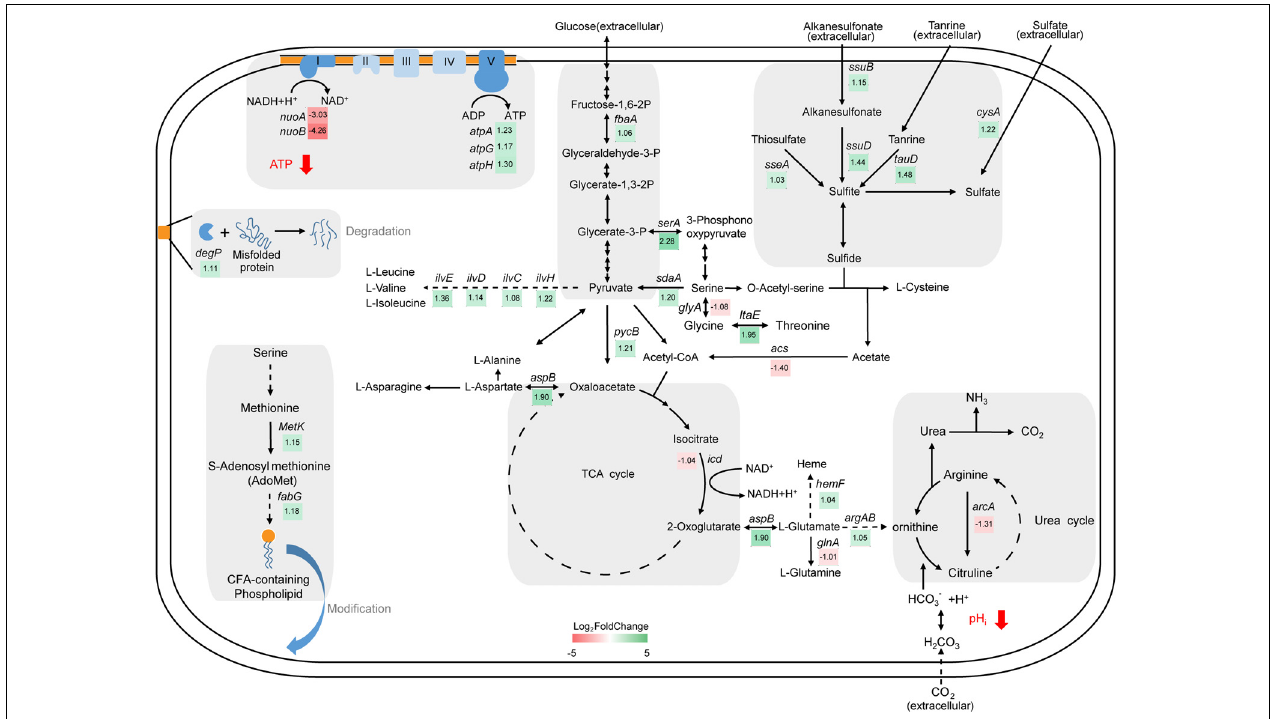
FIGURE 2 | Depiction of biological process changes (mainly in energy production and amino acid metabolism) in MAP samples based on the Kyoto Encyclopedia of Genes and Genomes (KEGG) database. Red indicates a lower expression level in MAP samples than in controls, and green indicates a higher expression level in MAP samples.